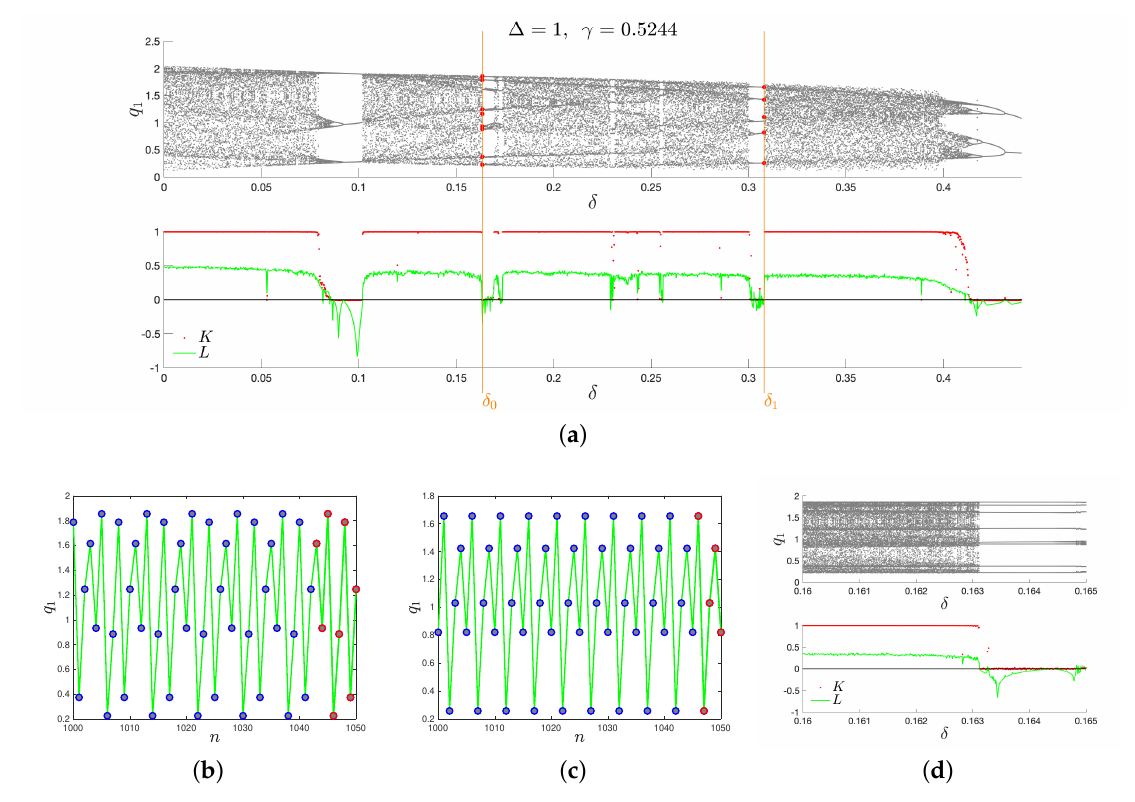
Figure 3. Investigated IHCOM Equation (11) with ∆ = 1 and γ = 0.5244: ( a-upper ) BD δ , ( a-lower ) chaos characteristics K and L for q 1 variable, ( b ) time history for δ 0 = 0.1634 (8 stable cycle highlighted by the red mark), ( c ) time history for δ 1 = 0.308 (5 stable cycle highlighted by the red mark), and ( d ) is magnified part of ( a